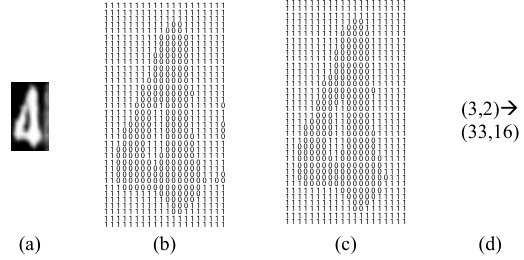
Fig. 4. Locating the character in a degraded gray image by DNRBM (a) original image (b) after distinguishing foreground from background (c) after wiping off mottles (d) the location of the foreground got after cutting margins